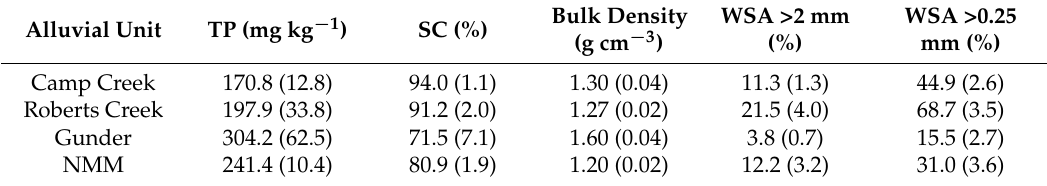
Table 3. Mean total phosphorus concentration and soil parameters of alluvial units, Walnut Creek, Iowa. Non-member material denoted by NMM. Silt-clay content by weight denoted by SC. Water stable macro-aggregates by weight denoted by WSA. Numbers in parentheses indicate standard errors. Alluvial Unit